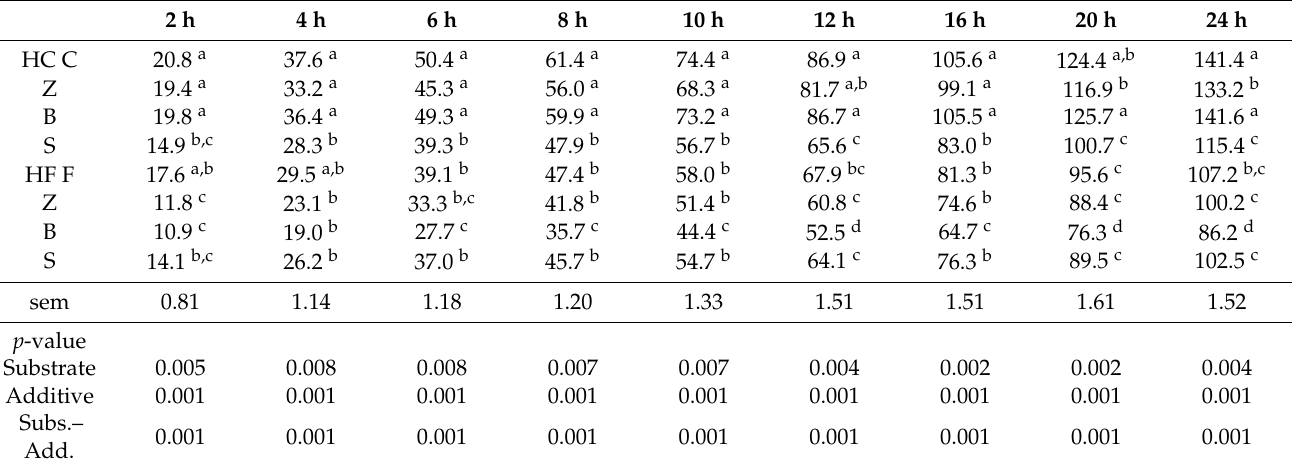
Table 2. Gas production (mL/g organic matter, OM) from a 65:35 (HC) or a 35:65 (HF) concentrate-to- forage substrate, alone (C, F) or supplemented with 10 mg/g of clay minerals (zeolite, Z; bentonite, B; or sepiolite, S). sem: standard error of means.